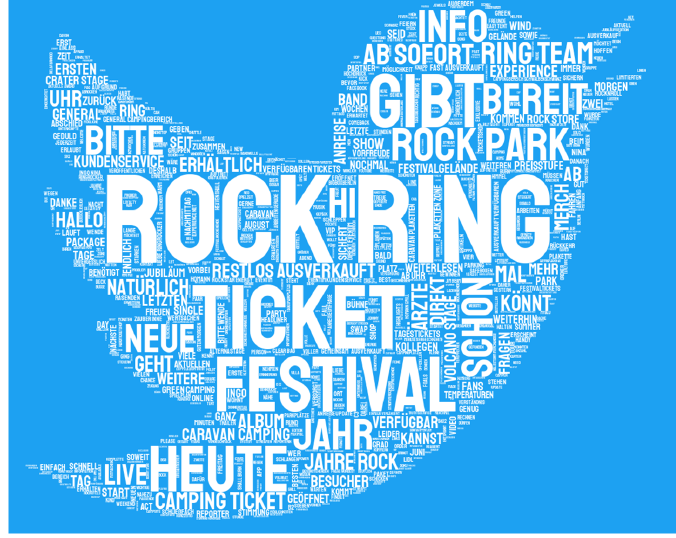
Figure 3. Standard keyword cloud for Twitter streams. The designer may use the keywords to search social media and the web for user comments that they can utilize for the persona construction.